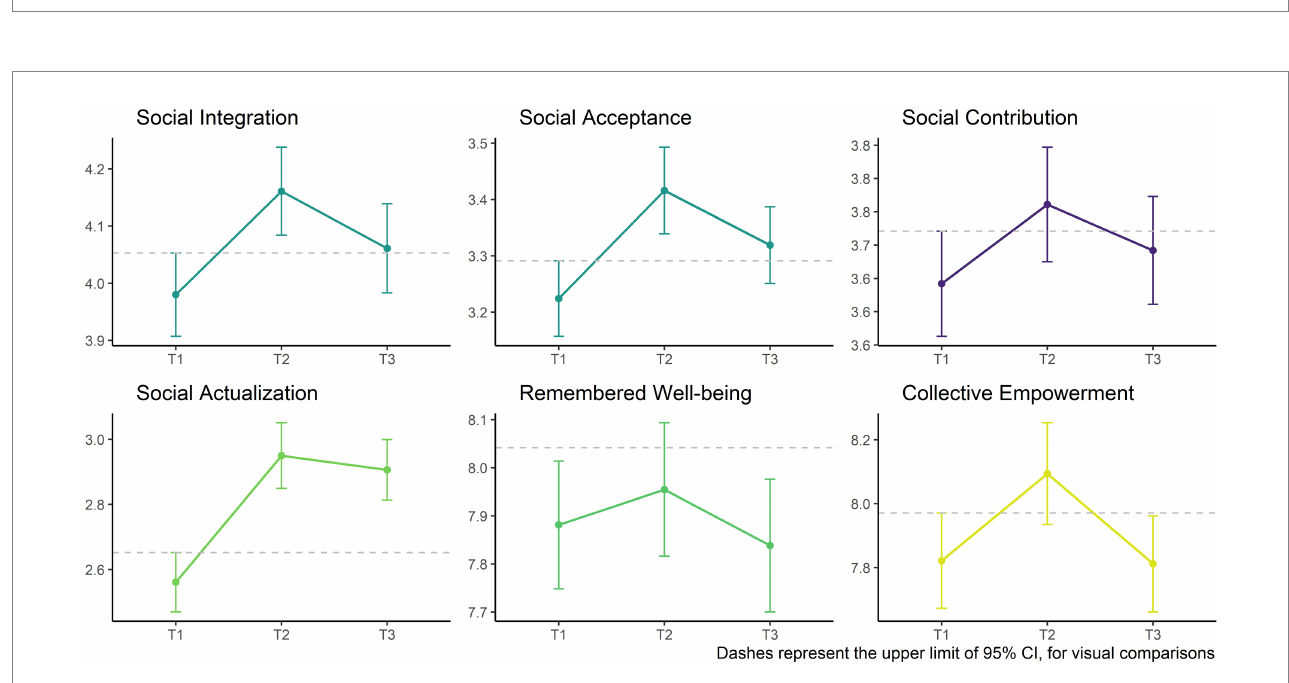
FIGURE 7 Results of repeated measures of dependent variables in T1, T2, and T3.